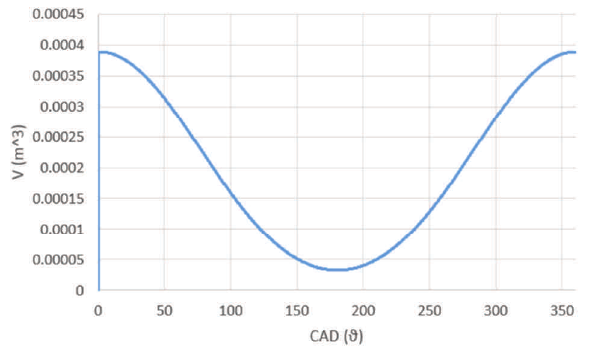
Fig. 4b. Graph of cylinder volume against CAD